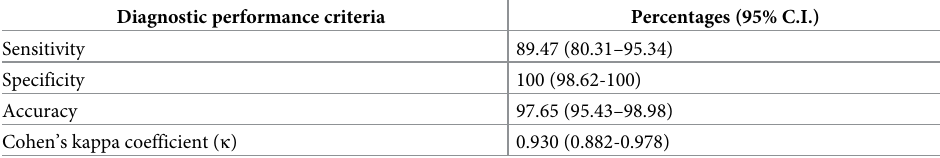
Table 4. Summary of diagnostic performance of GNA-MAb 4D1 sandwich ICT